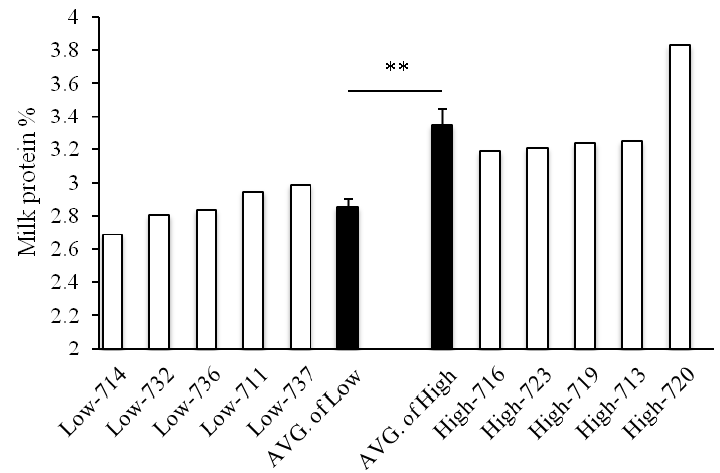
Figure 1. Milk protein contents of primiparous dairy cows (93.8 ± 11.56 milking days). ** p < 0.01.